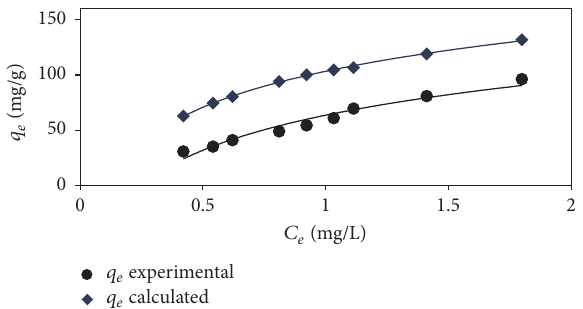
Figure 15: Jain and Snoeyink model for RB-5 in binary system with RR-RB (temp. = 25 ∘ C, speed = 200 rpm, time = 24hr., and con. of RR-RB = con. of RB-5 = 100mg/L).